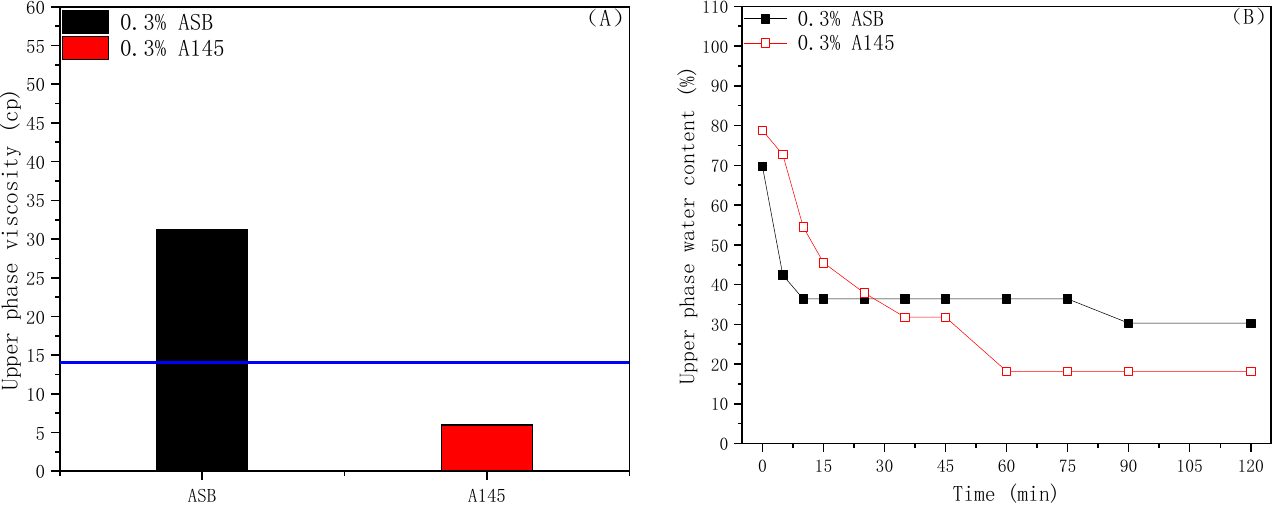
Figure 3. Upper phase viscosity ( A ) and water content ( B ) of ASB and A145 crude oil emulsion.